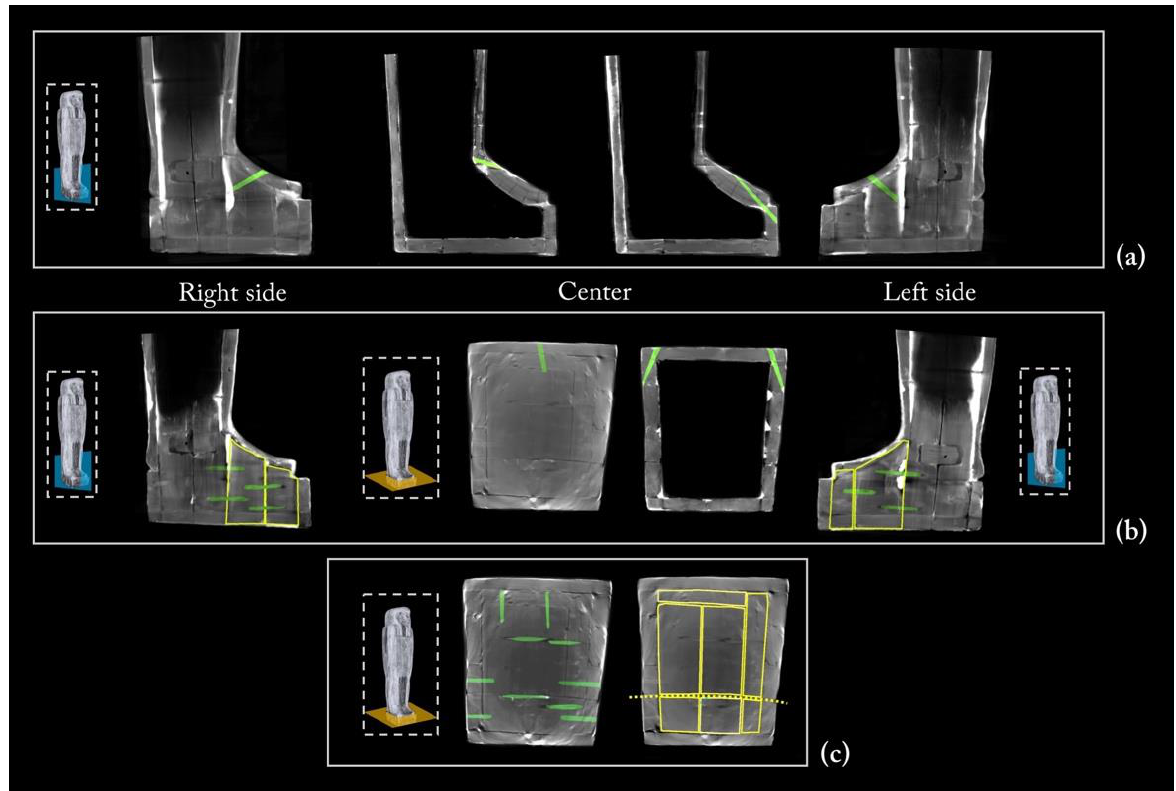
Figure 13. ( a ) Sagittal sections of the feet and pedestal showing the connecting dowels; ( b ) the wooden small planks that complete the front of the pedestal and the coffin sides with related dowels; ( c ) the planking of the foot board.